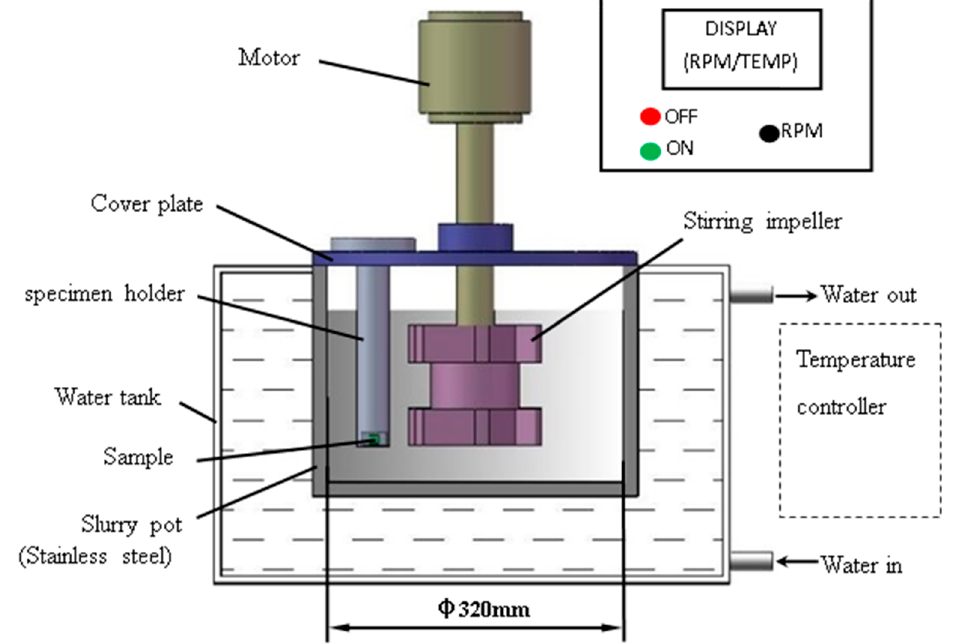
Figure 1. Schematic diagram of slurry pot erosion apparatus.